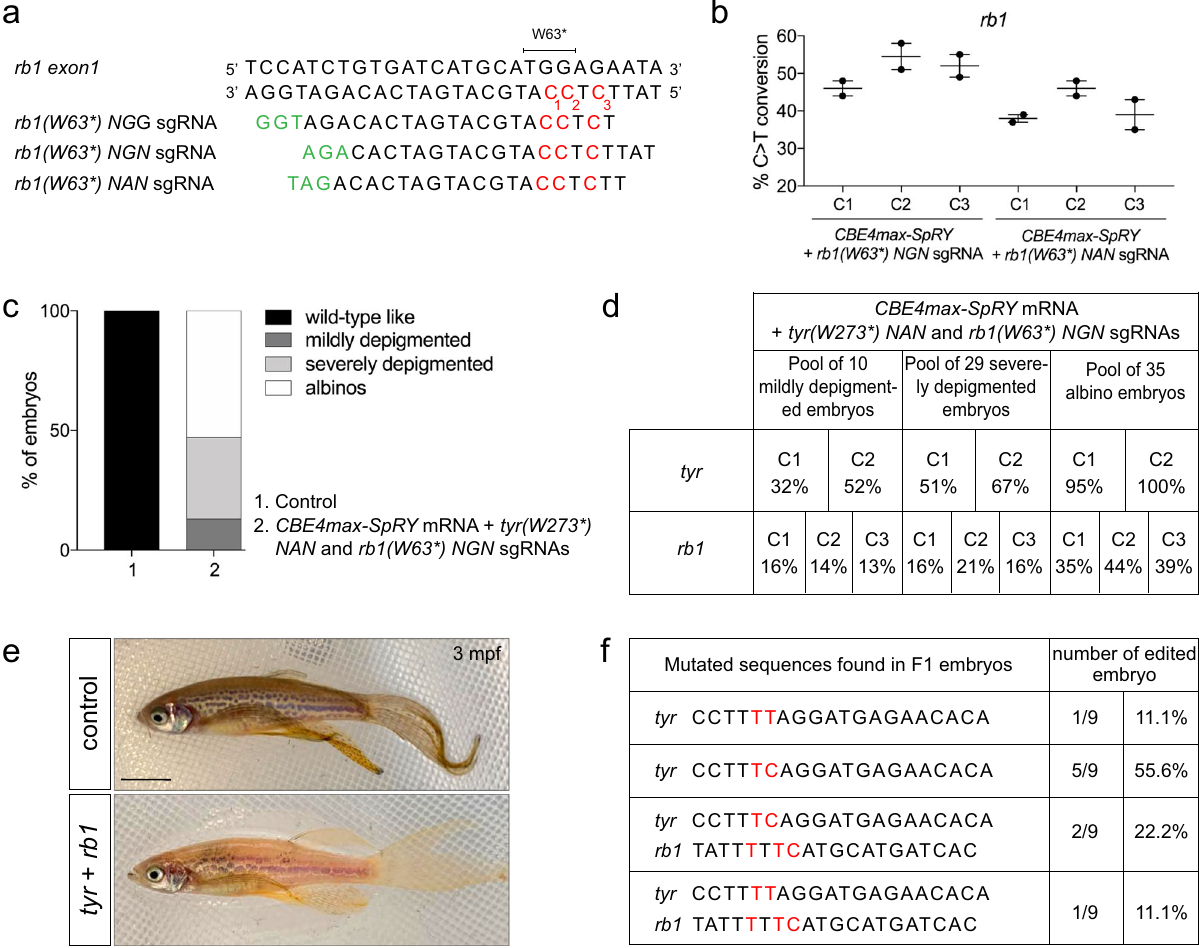
Fig. 2 Germline transmission of two mutations generated simultaneously using NAN and NGN PAMs. a Targeted genomic sequence of the rb1 tumor suppressor gene and the 3 different sgRNAs used to introduce the W63* mutation. For each sgRNA, the targeted Cs are in red and the PAM sequence is in green. b C-to-T conversion ef fi ciency for each targeted Cs in 2 pools of 9 embryos injected with CBE4max-SpRY mRNA and rb1(W63*) NGN or rb1(W63*) NAN sgRNAs. Dot plot showing the means and standard errors of the mean (SEM). c Proportion of the 4 groups based on the pigmentation lack defects described in Fig. 1c for embryos injected with the CBE4max-SpRY mRNA, the tyr(W273*)NAN , and the rb1(W63*)NGN sgRNA (column 2, 74 embryos in total). d C-to-T conversion ef fi ciency for each targeted Cs and each pool of embryos showing pigmentation defects presented in c for the tyrosinase and rb1 genes. The ef fi ciencies have been calculated using EditR tool 42 and chromatograms from Sanger sequencing of PCR products. e Lateral view of a 3 months F0 fi sh injected at one-cell stage embryo with the CBE4max-SpRY mRNA, the tyr(W273*)NAN , and the rb1(W63*)NGN sgRNAs and showing pigmentation defects. Scale bar = 5 mm. f Sequenced tyr and rb1 loci of 9 F1 single embryos from the founder fi sh in e . Six embryos out of 9 were single edited for tyrosinase and 3 embryos out of 9 were double edited for tyrosinase and rb1